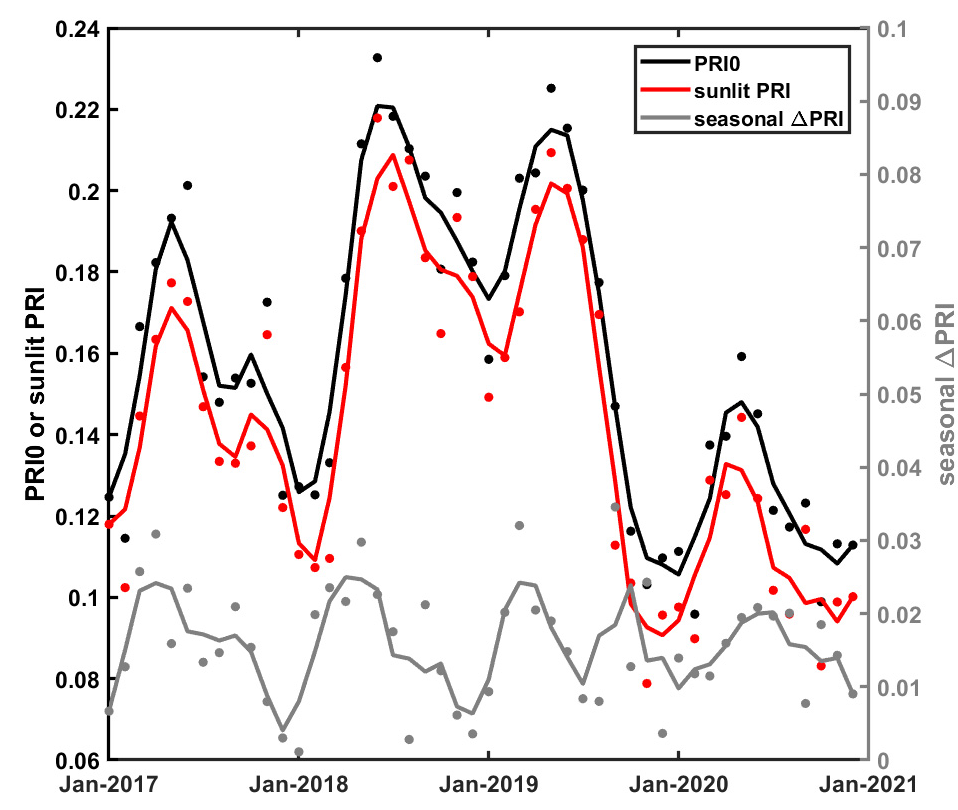
Figure 4. Seasonal and inter-annual variations in monthly (dotted) PRI0, sunlit PRI, and seasonal ∆ PRI from January 2017 to December 2020. Lines indicate the 3-month moving average of monthly values. PRI = photochemical reflectance index.